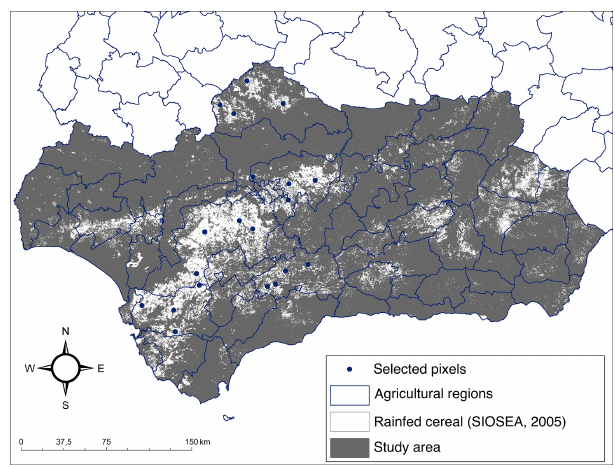
Figure 1. Location of the study area (grey) and selected repre- sentative points (blue dots) within the areas cultivated with cereal